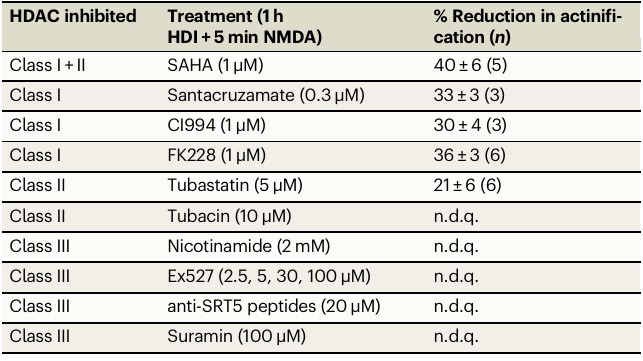
Table 1 | HDAC inhibitors (HDI) and their ef fi cacy in reducing NMDA-induced actini fi cation HDAC